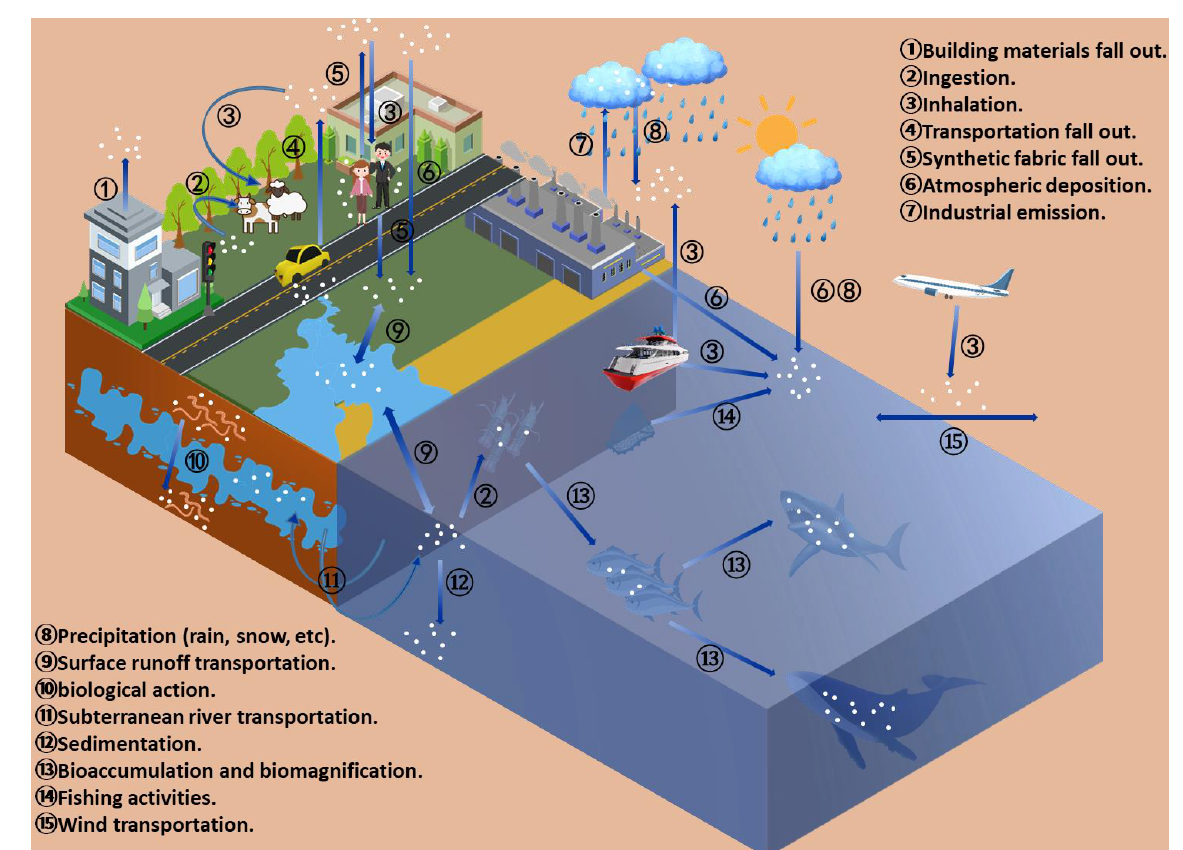
Figure 1. Cycle of microplastic pollution in ecosystems.